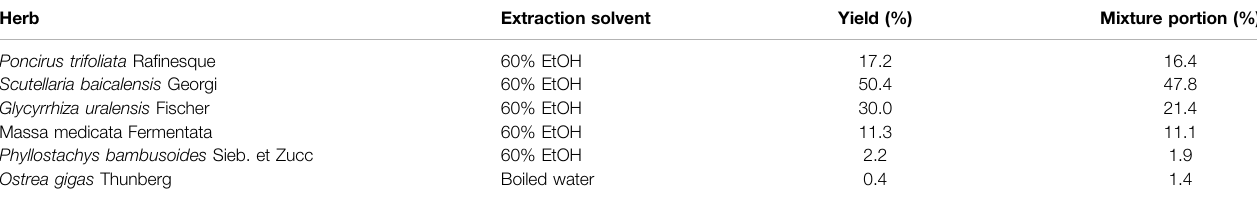
TABLE 1 | The yield and mixing portion of herbal medicines comprising Yeokwisan